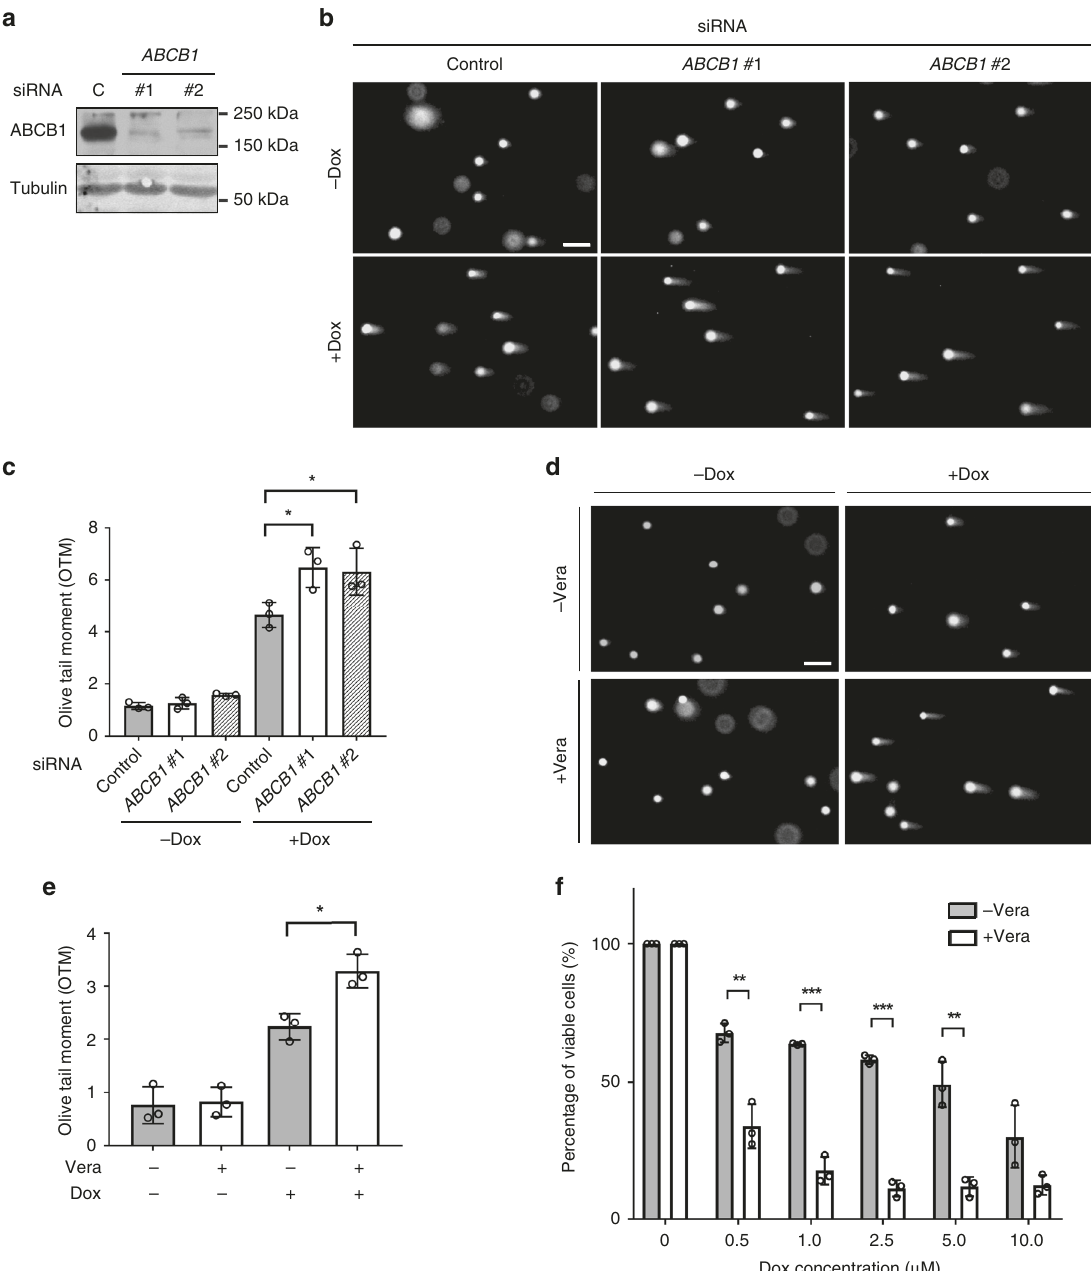
Fig. 6 Effect of ABCB1 knockdown on doxorubicin-induced DNA damage in bat cells. a The ef fi ciency of siRNA knockdown. PaKiT03 cells were transfected with the indicated siRNA, and the expression of ABCB1 was analysed by Western blotting. C; control siRNA. Tubulin was used as a loading control. b Comet assay of PaKiT03 cells. siRNA knockdown cells were treated without or with 10 µ M doxorubicin (Dox) for 3 h, and DNA damage was visualised by comet assay. c Quanti fi cation of the amount of DNA damage calculated by olive tail moments (OTM) for the cells in ( b ). d Comet assay of PaKiT03 cells. Cells were pre-treated without or with 5 µ M verapamil (Vera) for 30 min before the treatment with 10 µ M doxorubicin alone or together with Vera for an additional 3 h. DNA damage was visualised by comet assay. e Quanti fi cation of the amount of DNA damage calculated by OTM for the cells in ( d ). f Quanti fi cation of cell viability. Cells were pre-treated without or with 5 µ M verapamil for 30 min before the treatment with the indicated amount of doxorubicin alone or together with verapamil for an additional 3 h. Doxorubicin was then removed and replaced with the doxorubicin-free medium in the absence or presence of verapamil for 72 h before measuring cell viability. Cell viability (%) is presented relative to the control cells (the fi rst grey bar). All data shown have at least three experimental repeats and the images are representative. Scale bar represents 50 µ m. Bars represent the means ± SDs of three independent experiments. Statistical signi fi cances were calculated using unpaired student ’ s two-sided t test. p < 0.05 is represented with *, p < 0.01 with ** and p < 0.001 with